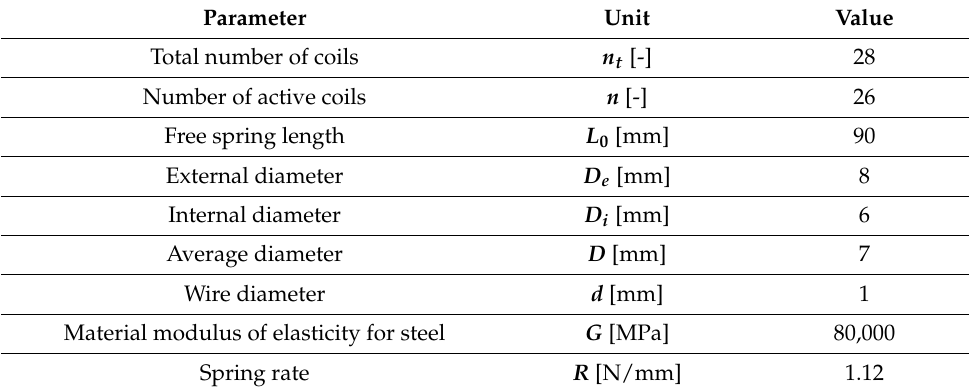
Table 7. The parameters of the compression spring. Parameter Unit Value Total number of coils n t [-] 28 Number of active coils Free spring length External diameter